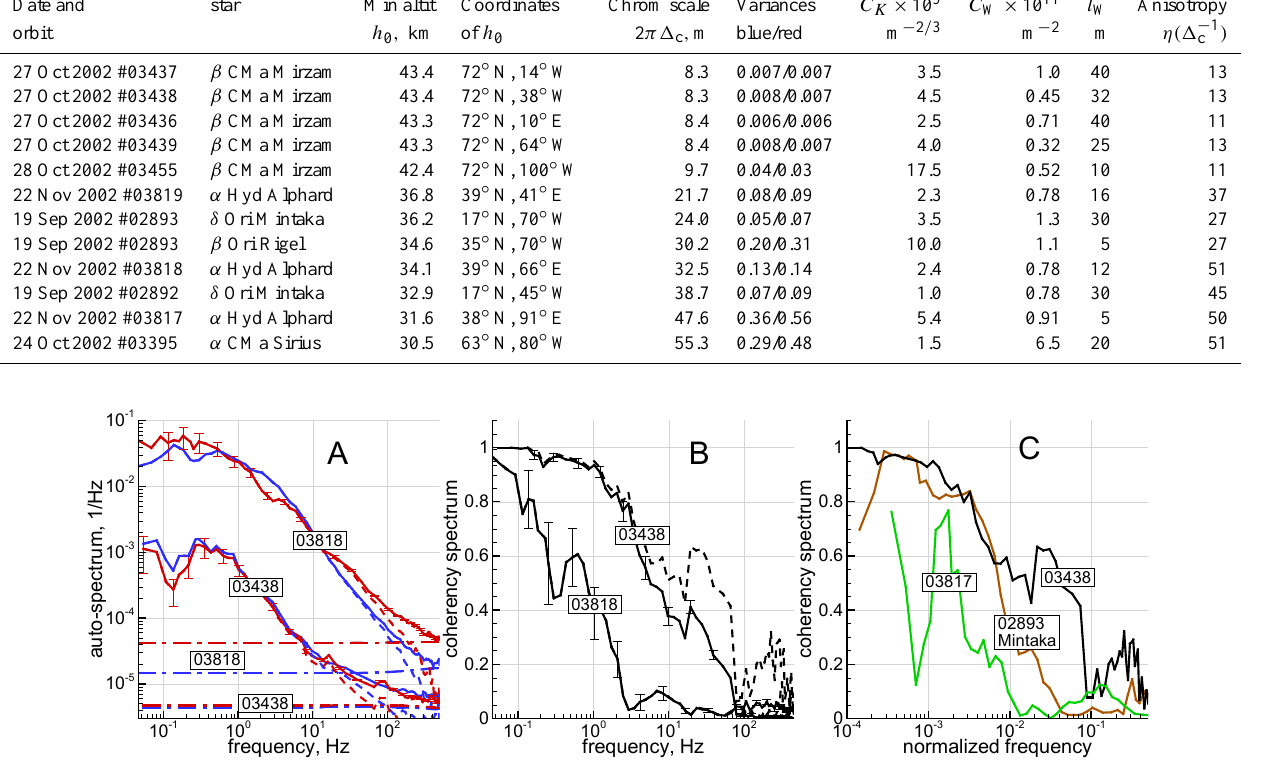
Table 1. Information about the selected tangential occultations Date and